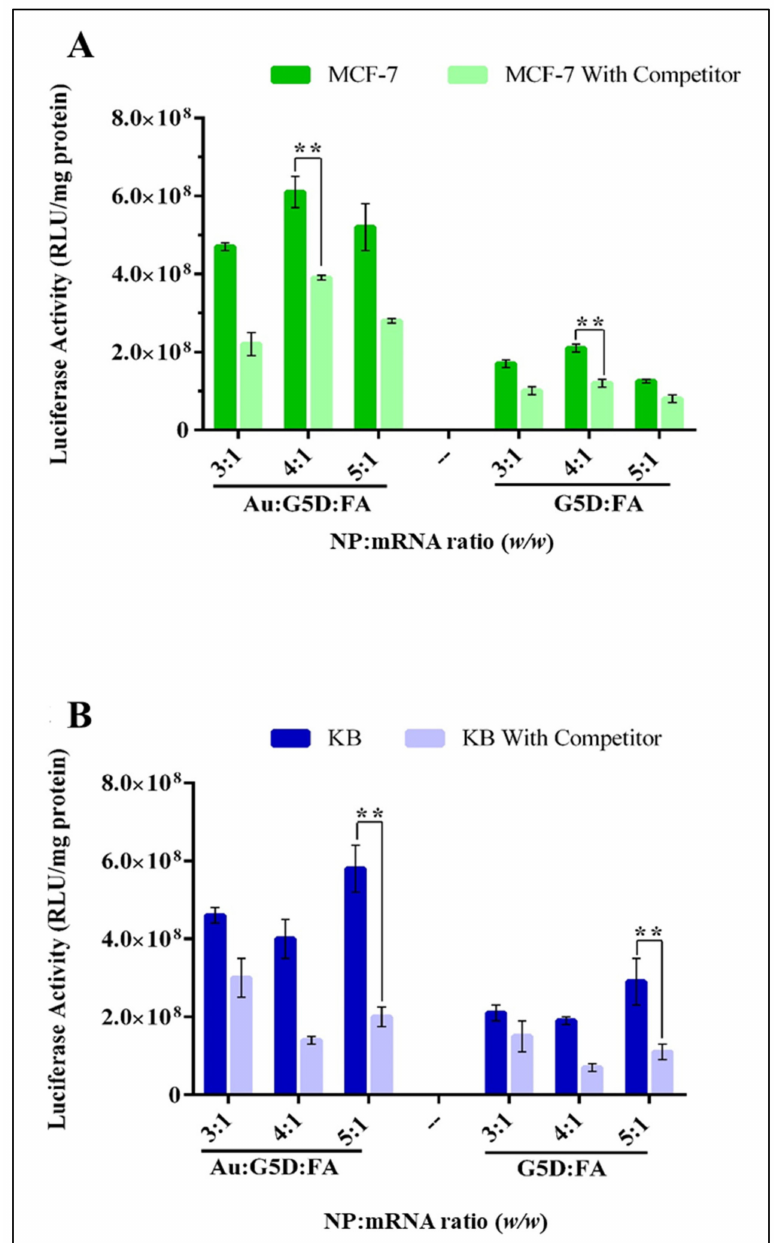
Figure 10. Competition studies of FA-targeted mRNA nanocomplexes in ( A ) MCF-7 and ( B ) KB cells. Cells were first exposed to excess folic acid (250 µ g) then treated with FA-targeted nanocomplexes at selected ratios. Transgene expression is reported as RLU/mg protein. Data are presented as means ± SD ( n = 3). ** p <